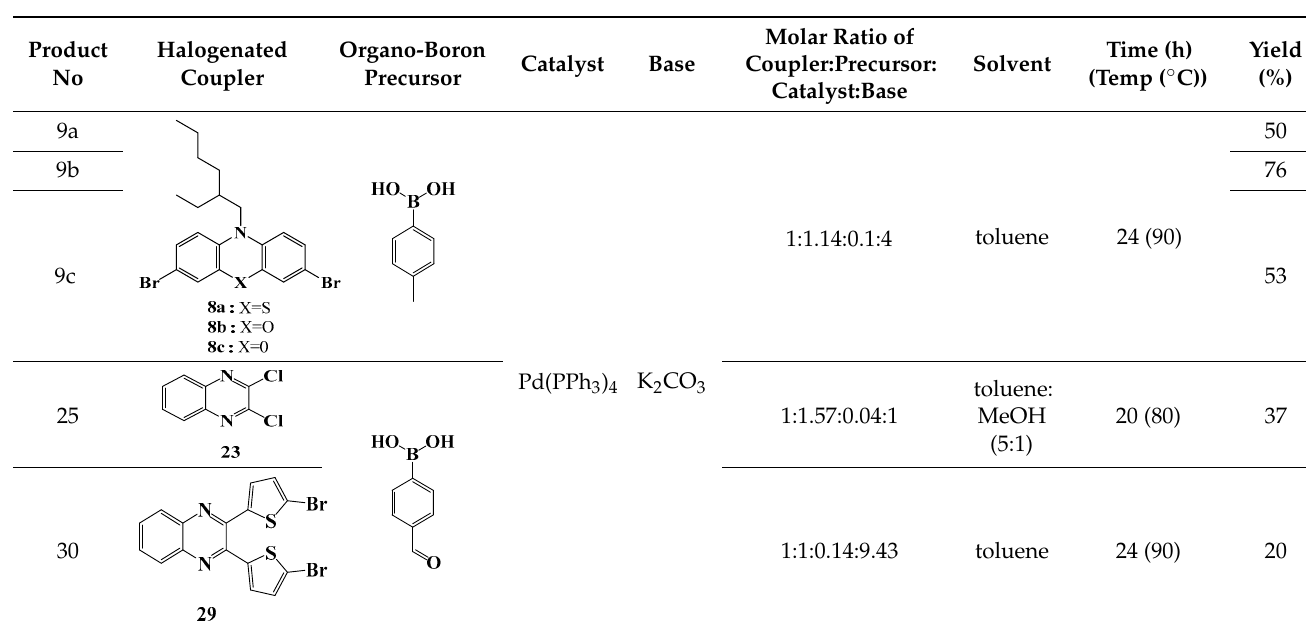
Table 2. Summary of Suzuki cross-coupling reactions of halogenated N -alkyl PTZ, POZ Cz, and QX couplers with commercial arylboronic acid precursors.